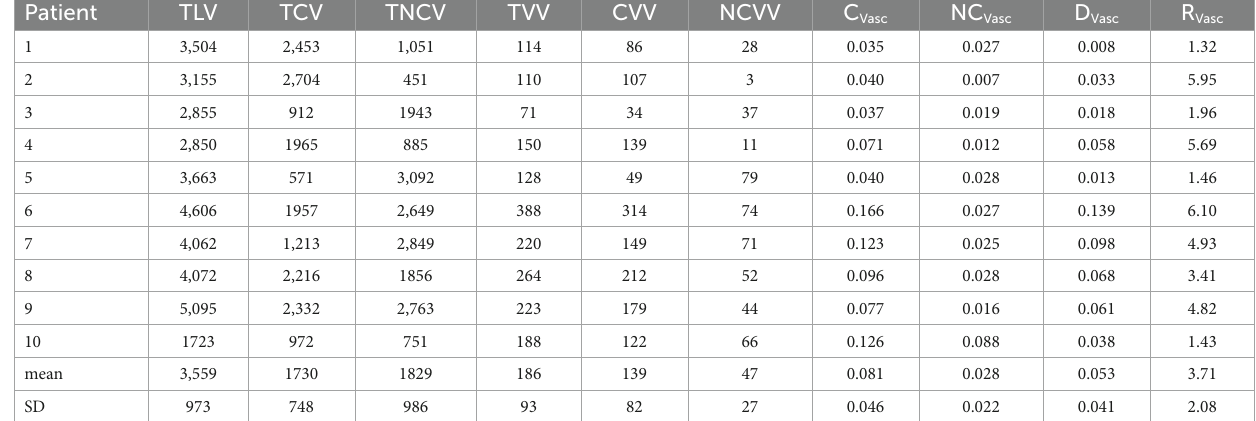
TABLE 2 Total lung volume (TLV), total COVID volume (TCV), total non-COVID volume (NCV), COVID vascular volume (CVV), non-COVID vascular volume (NCVV), proportion of vascular volume in COVID areas (C vasc ), proportion of vascular volume in non-COVID areas (NC Vasc ), difference of vascular volume proportions between COVID and non-COVID areas (D Vasc ), ratio of vascular volume proportions between COVID and health areas (R Vasc ), in 10 COVID-19 patients.